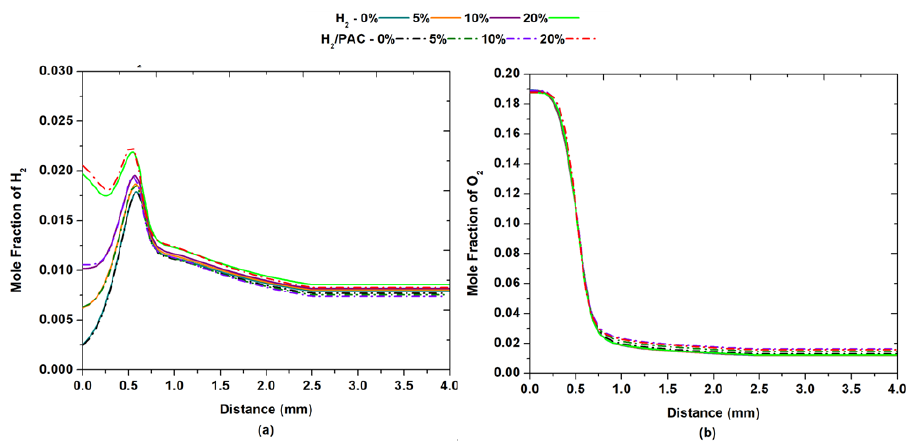
Figure 11. Rate of production of O, H, and OH with different blends of hydrogen without or with NSPD.